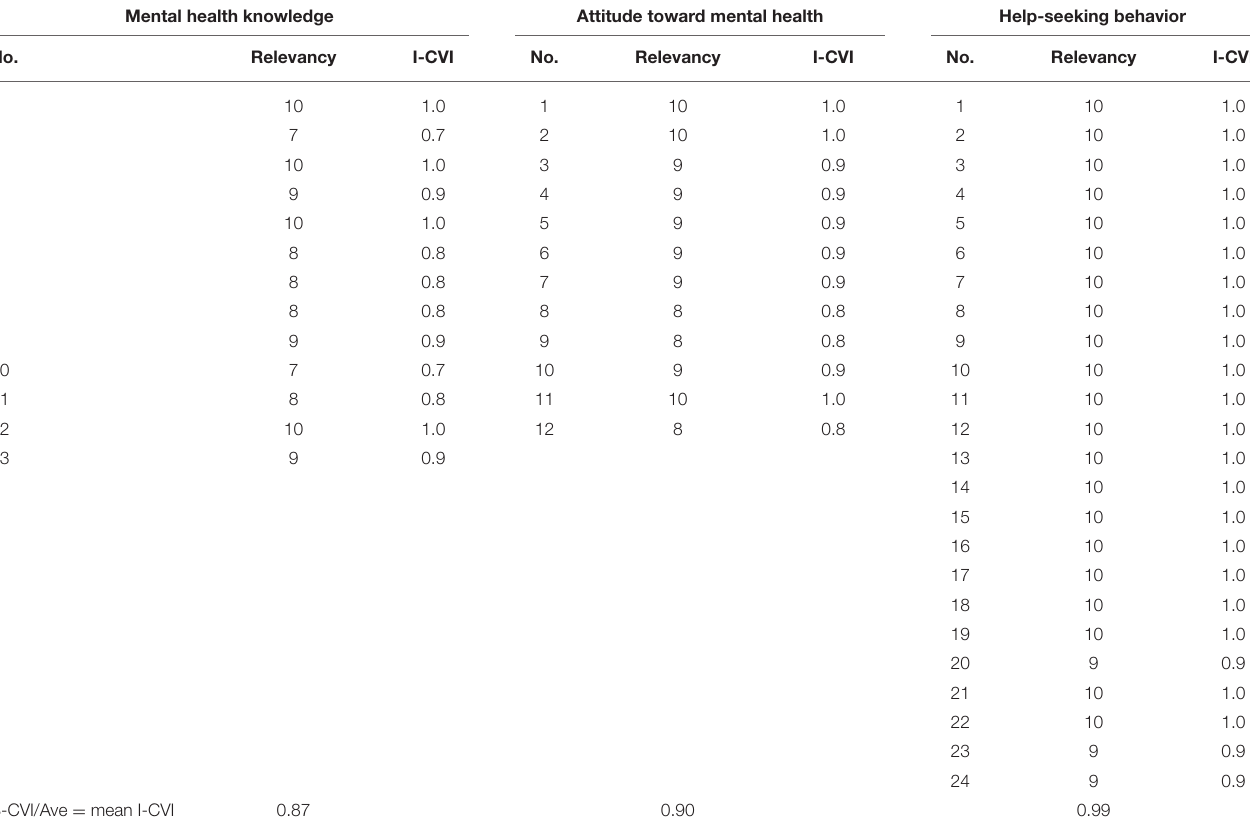
TABLE 2 | Validity test of the Indonesian mental health literacy and help-seeking behavior set of questionnaires. Mental health knowledge Attitude toward mental health Help-seeking